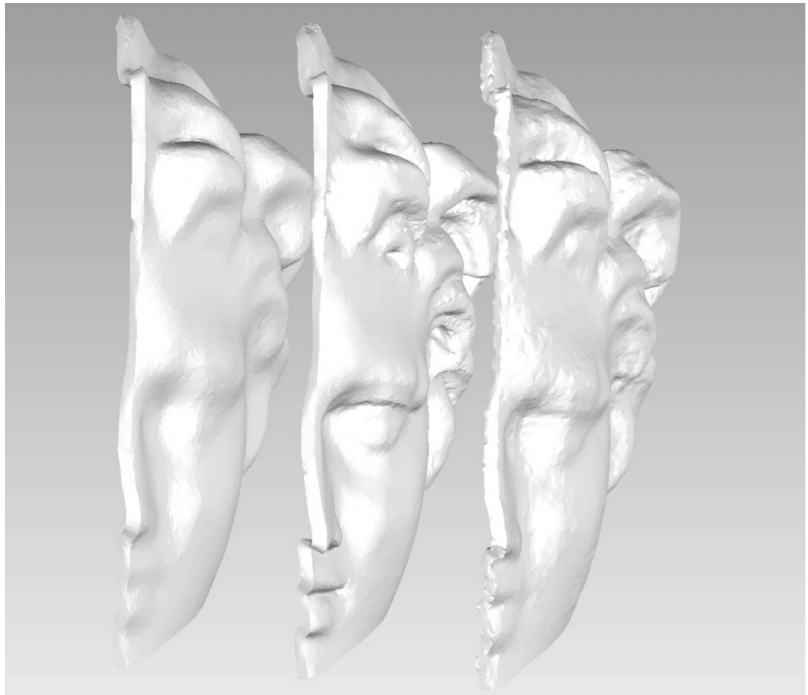
Figure 12. The three digital models: from the left: the first photogrammetric model, the laser-scanning model, and the second photogrammetric